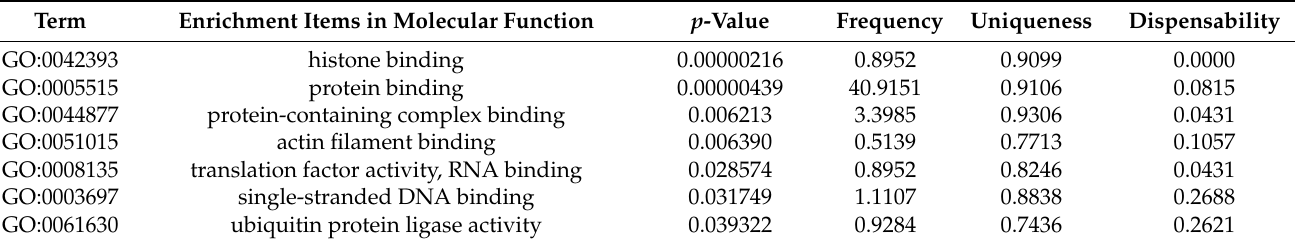
Table 6. Non-redundant enrich items in molecular function of gene ontology identified by REVIGO analysis.